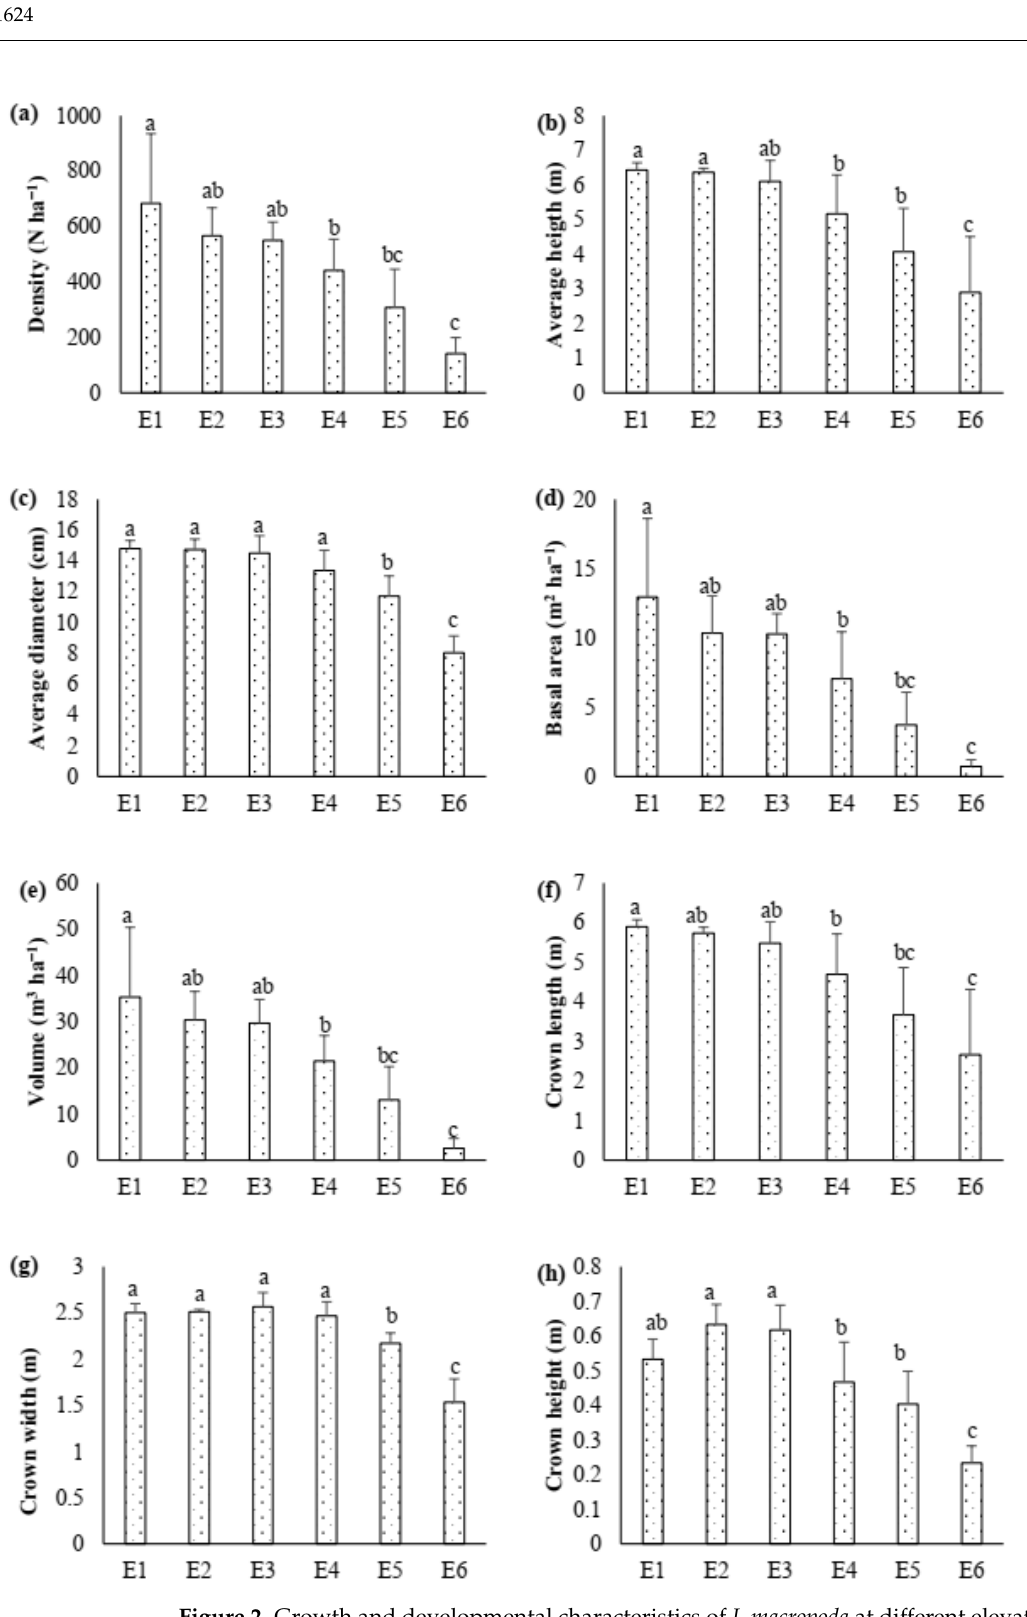
Figure 2. Growth and developmental characteristics of J. macropoda at different elevation ranges in north-western Himalaya where: ( a ) denotes density (N ha − 1 ), ( b ) average height (m), ( c ) average diameter (cm), ( d ) basal area (m 2 ha − 1 ), ( e ) volume (m 3 ha − 1 ), ( f ) crown length (m), ( g ) crown width (m) and ( h ) crown height (m). The error bar shows the mean standard deviation. Different letters ( abc ) indicate significant differences at p <